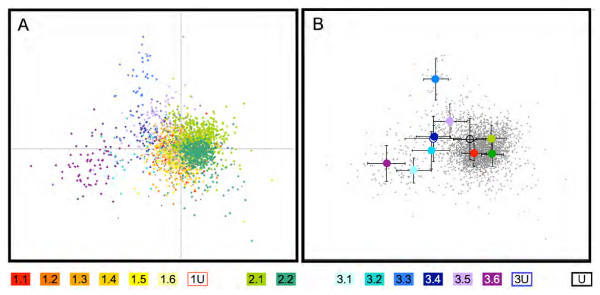
Multifactorial analysis of Pisum diversity. For the entire data set the fraction of shared alleles for all pair-wise combinations of samples is analysed by multidimensional scaling. The output for the first two dimensions (explaining 5.32% and 2.99% of the variation are shown (see text). A: All points are plotted with each sample is colour-coded according to its corresponding sub-group membership. B: The mean of all values for each sub group, together with standard deviations are plotted. Sub Groups are colour coded as shown below. The subgroups of Group 1 lie so close together that they are not individually identified but collectively represented in red. All points are plotted in grey and the axes are removed for clarity.